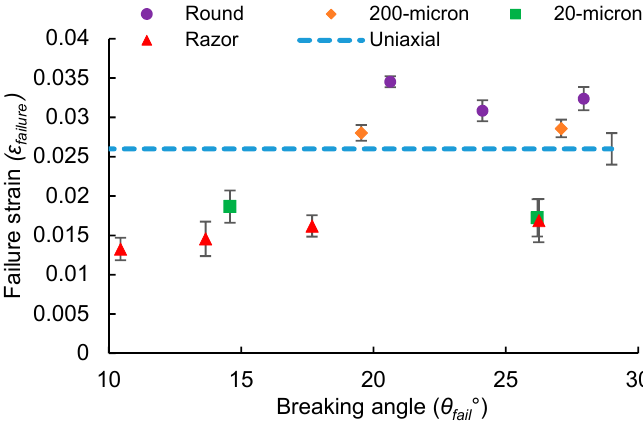
ff ect of breaking angle on axial failure strain for di ff erent indenter Figure 10. Effect of breaking angle on axial failure strain for different indenter geometries. Figure 10. E